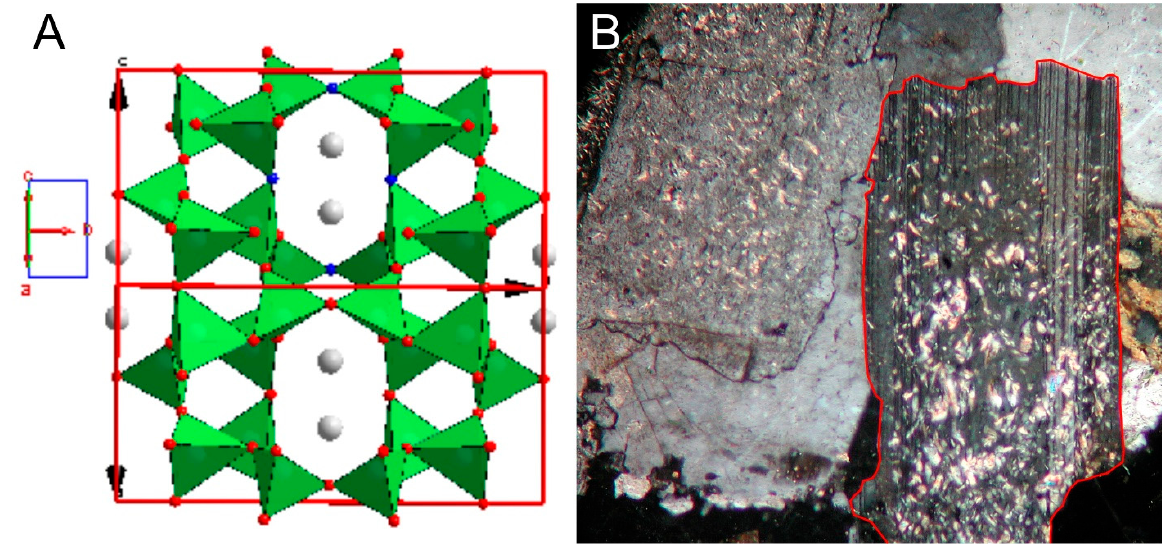
Figure 5. ( A ) Projection of the K-feldspar structure along the (101) direction with K (grey) in the channel; ( B ) sericitization alteration happened in the interior of K-feldspar crystal (e.g., red line). A water molecule has a diameter of 0.276 nm, and its radius is 0.138 nm [61]. The order of ionic radius occupied in framework structure is K + (0.155 nm, coordination 9) > Na + (0.102 nm, coordination 6) > Ca 2+ (0.100 nm, coordination 6) [62]. Considering the